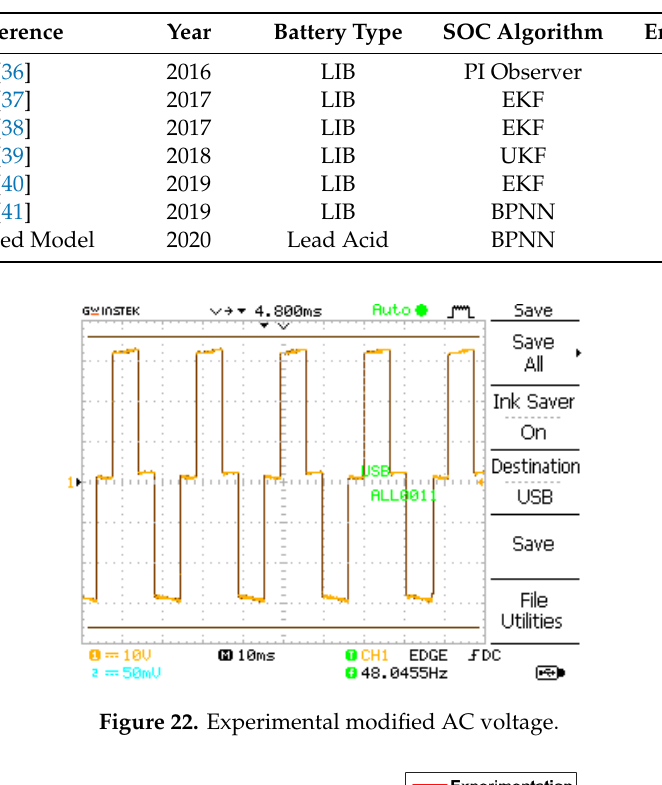
Table 3. SOC estimation accuracy comparison.